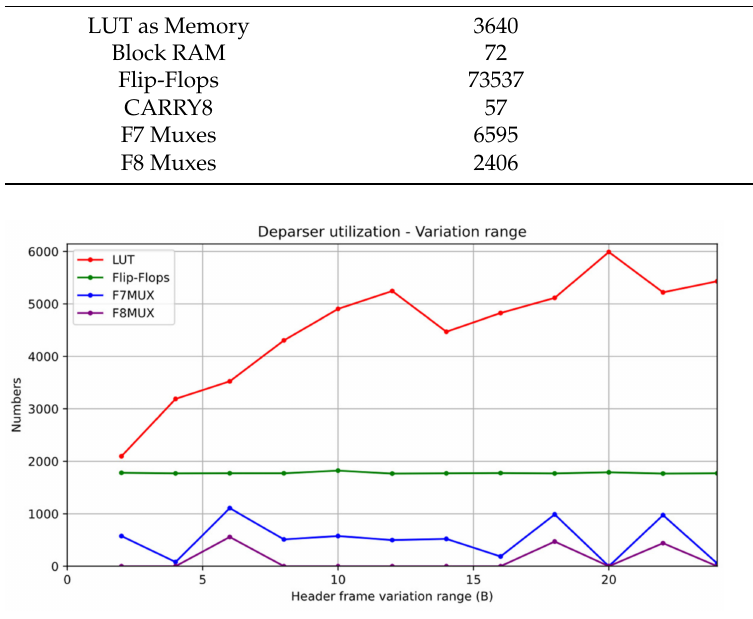
Figure 7. Utilization of deparsers in different variation